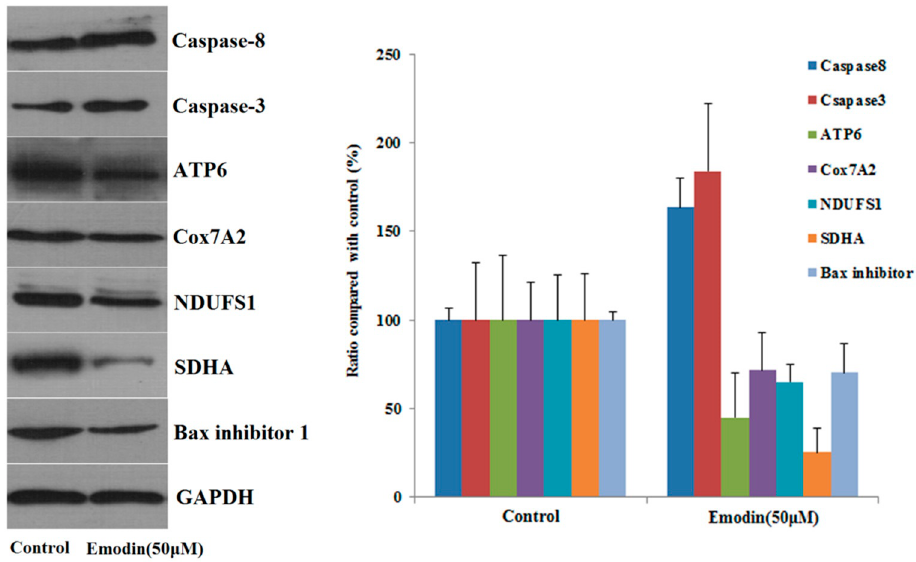
Figure 6. The expression of seven protein in L02 cells after treated with emodin for 48 h, (means ± SD, n = 3).